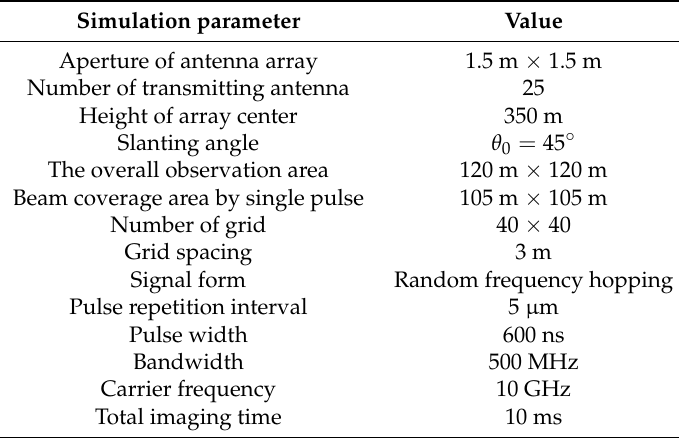
Table 1. Simulation